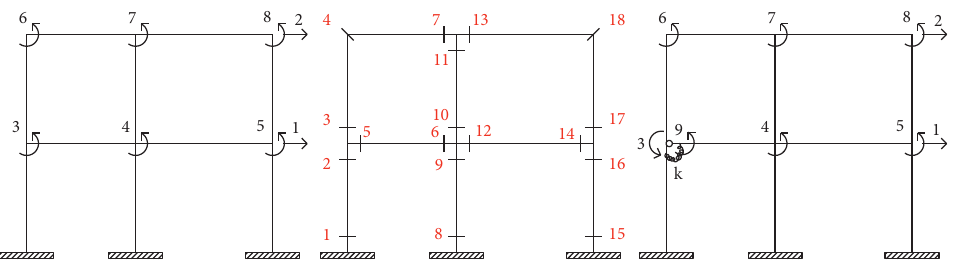
Figure 2: Degrees of freedom and critical sections of a frame with one